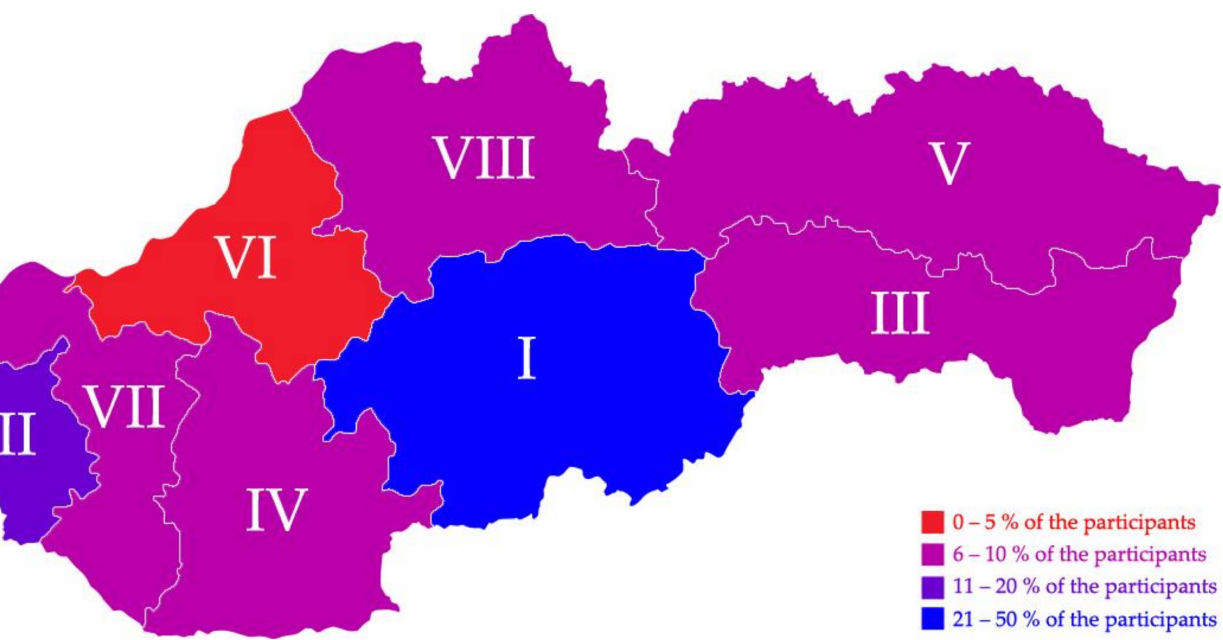
Figure 1. Geographic distribution of participating Slovak healthcare workers, February–March 2021 ( n =